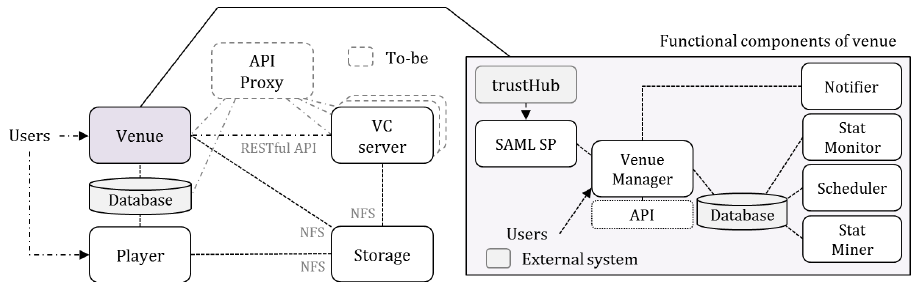
Figure 3. System architecture and software